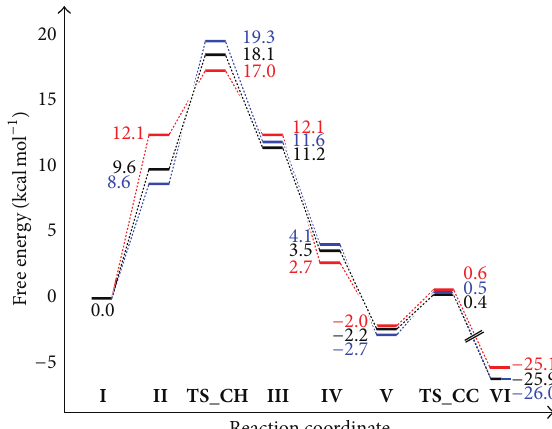
Figure 2: Computed free energy profiles for the different pheny- lacetylenes, color code: R = p -H ( black ), p -NO 2 ( red ), and p -Me ( blue